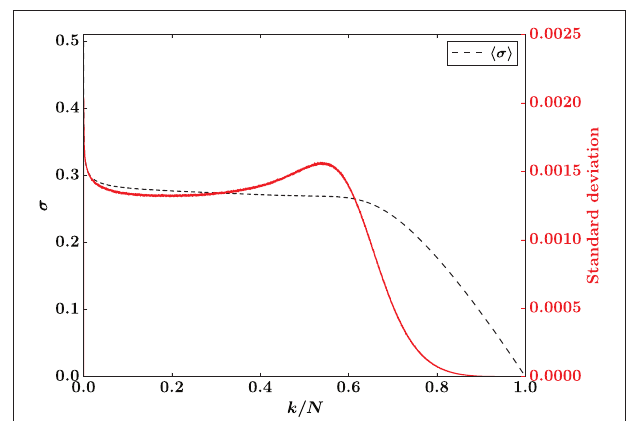
FIGURE 4 | Sample averaged load curve for the LLS model (black, left axis) and corresponding standard deviation (red, right axis) for a uniform threshold distribution on [0.5,1). Results are from simulations on a square lattice ( N = 128 2 ) with 1.5 × 10 5